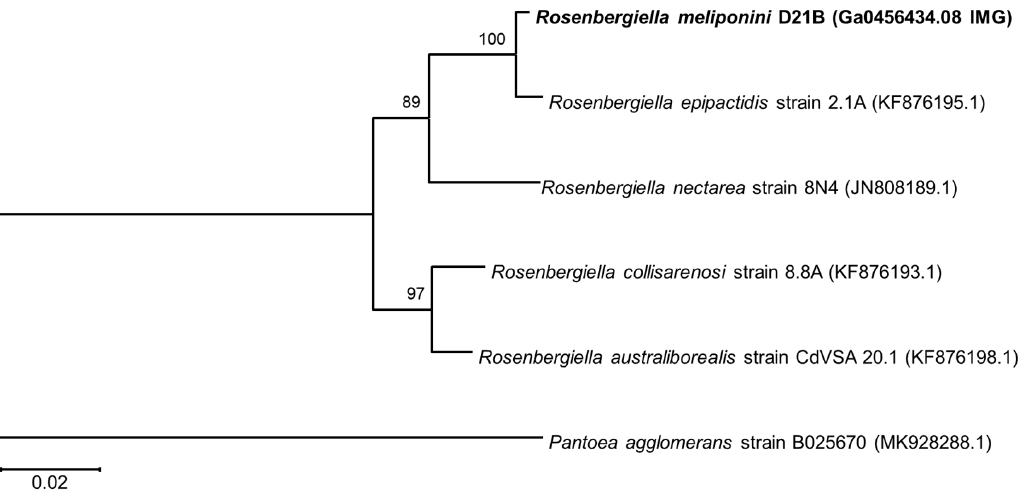
Figure 3. Neighbor-joining phylogenetic tree based on atpD gene sequences. R. meliponini D21B atpD, and R. epipactidis 2.1A atpD shared 99.19% sequence identity. With R. nectarea, R. australiborealis and R. collisarenosi R. meliponini D21B shared < 96.08% sequence identity. Bootstrap values > 50% calculated from 1000 replicates are indicated at branching nodes. Scale bar indicates 0.02 substitutions per nucleotide position.